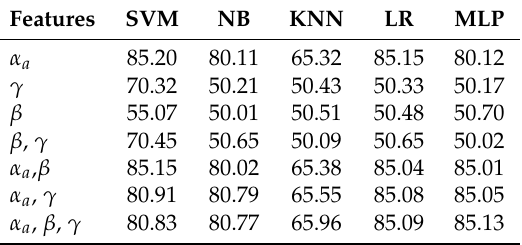
Table 5. Accuracy of classifiers for various combinations of statistically significant features.